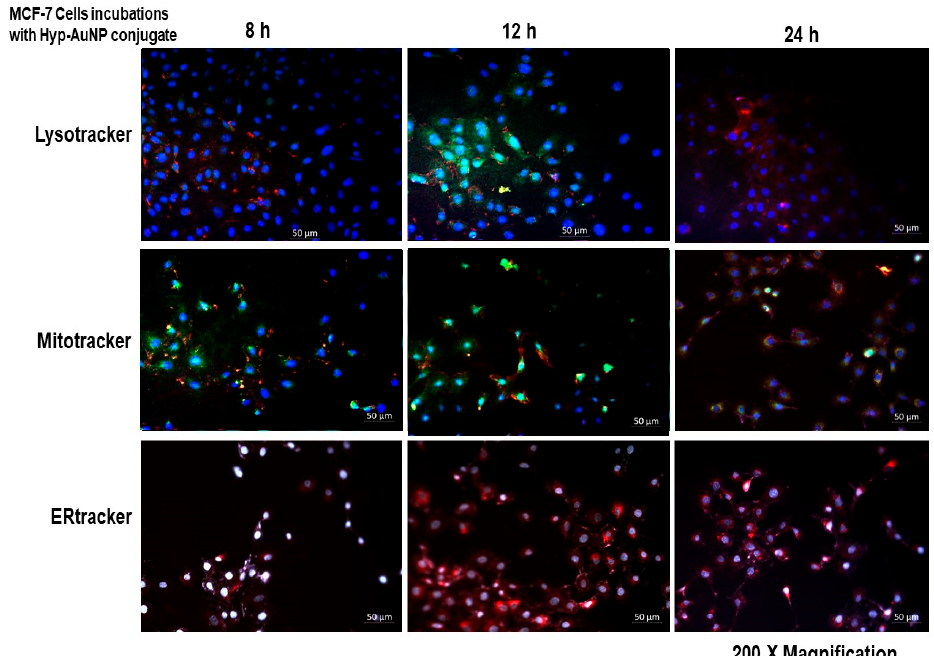
Figure 4. Hyp-AuNP compound localization in MCF-7 cells showing Hyp-AuNP accumulation in the cytoplasm, lysosomes (lysotracker-green) and mitochondrion (mito-tracker-green) at 12 h, indicated by the orange color (mixture of green and red) (Hyp-AuNP). No significant Hyp-AuNP localization on the endoplasmic reticulum (ER tracker) was observed at any incubation time. Cell nuclei were counterstained with DAPI (blue).